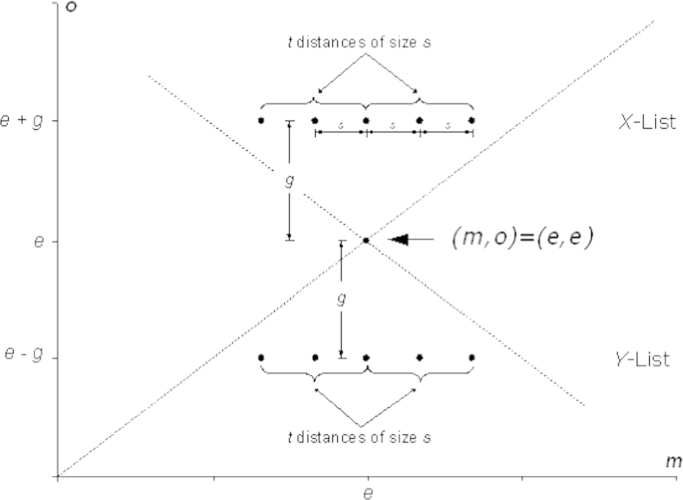
The geometry of the Equality Equivalence Test.